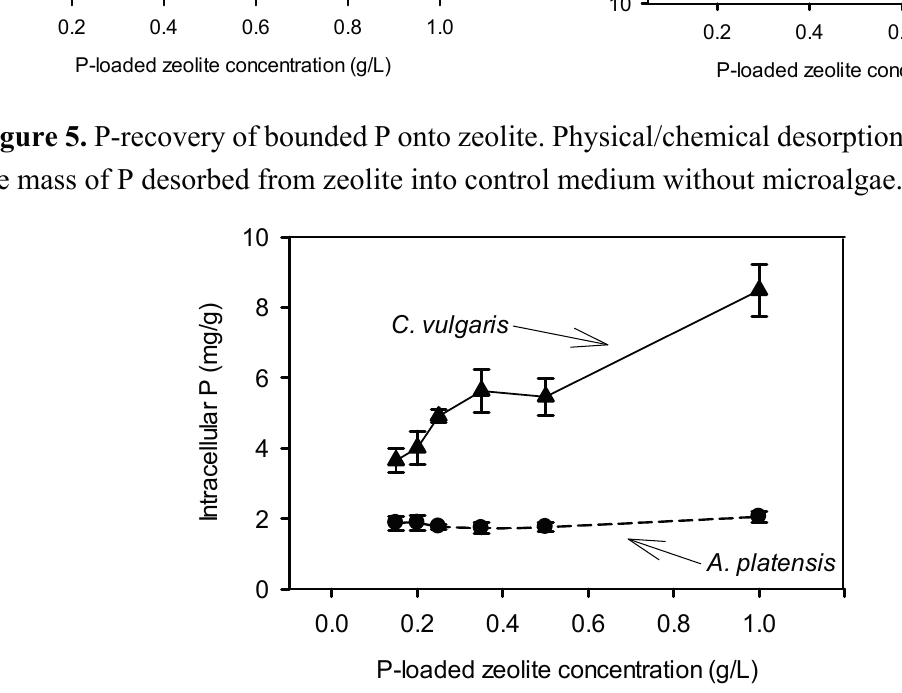
Figure 6. Intracellular P against concentration of P-loaded